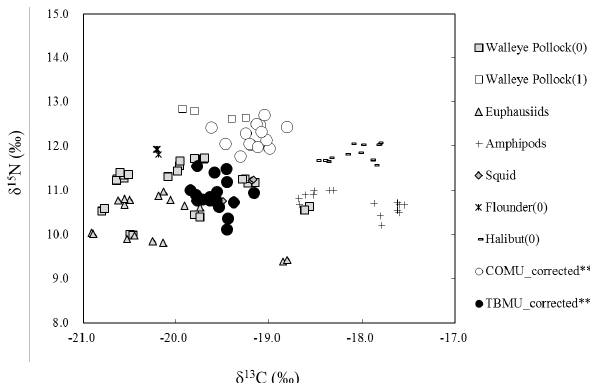
Figure 6. Carbon ( δ 13 C) and nitrogen ( δ 15 N) stable isotopic ratio values of potential food samples caught around the vicinity of the study colony. Different symbols represent each potential food item. ∗∗ The enrichment factors − 0.19‰ for δ 13 C and 2.25‰ for δ 15 N were preliminarily applied to the bird data (open circles for com- mon murres and closed circles for thick-billed murres). Note that the potential food samples were collected in 2009, as no data were available in 2014.